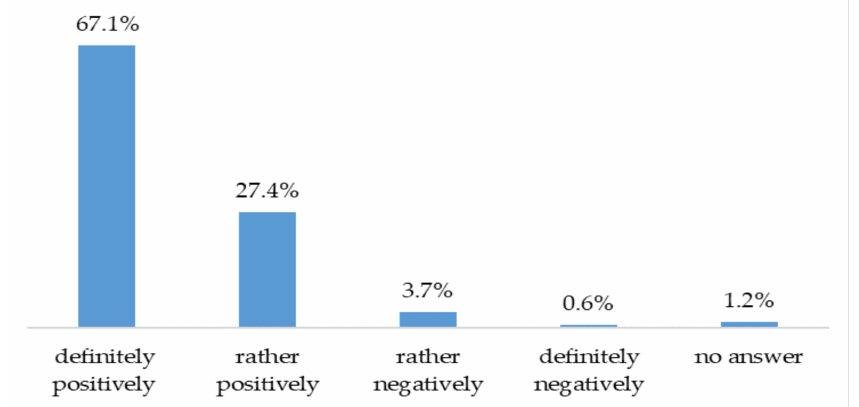
Figure 7. Evaluation of the decision to move to the countryside. Source: own study based on research